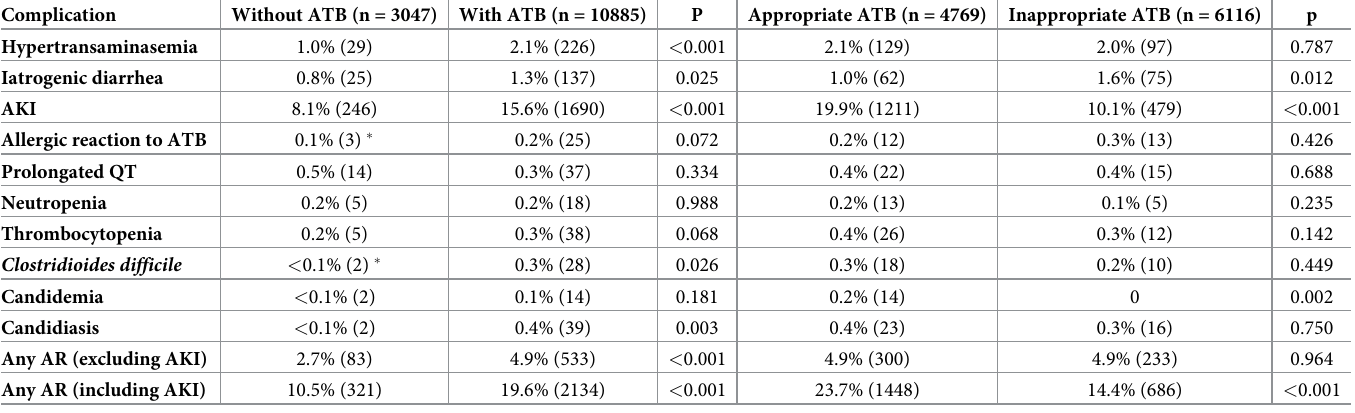
Table 4. Comparison of incidence of complications potentially associated with